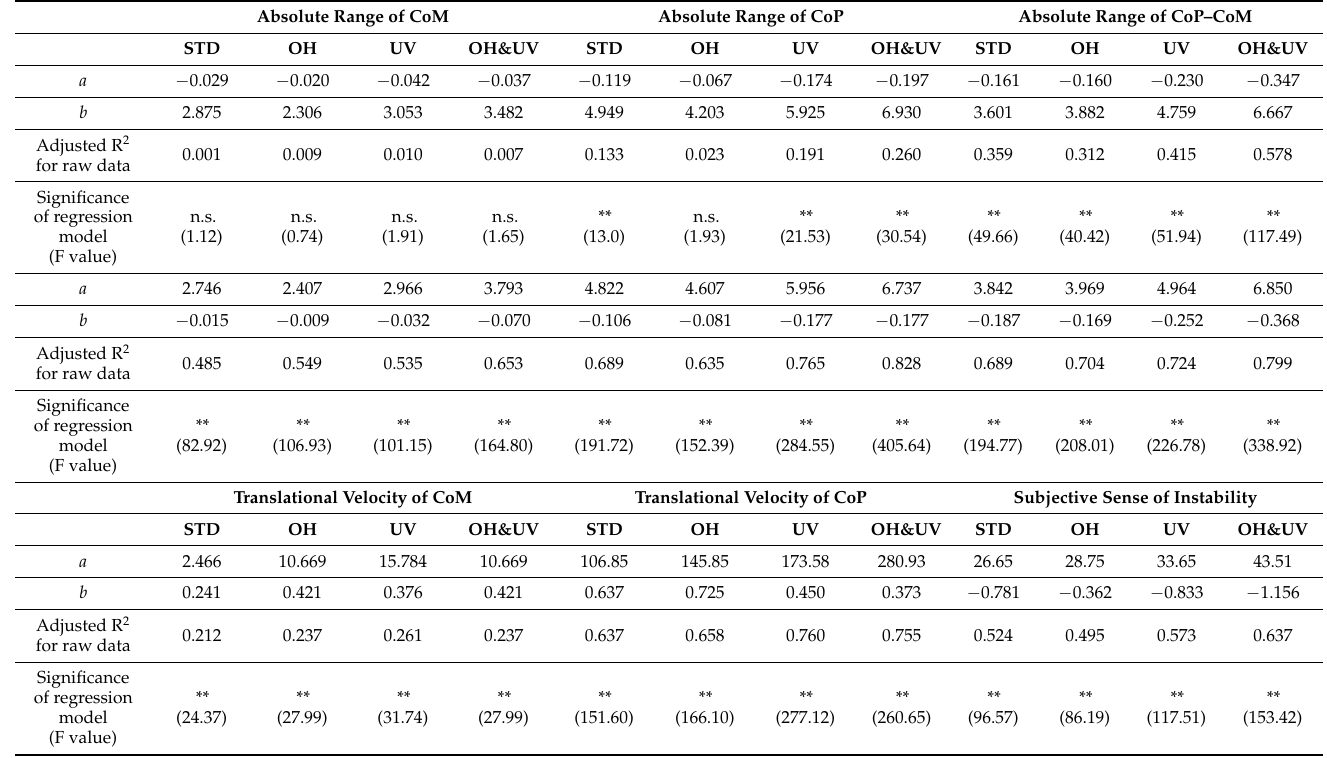
Table A2. Coefficients of fitting functions for kinematical indices and the significance test of regression model (** p < 0.01; n.s.: not significant). The models of the fitting functions were the linear for the platform depth ( y = a × d + b ) for the absolute range, the reciprocal of the platform depth ( y = a / d + b ) for the relative range and the subjective sense of instability, and the negative square of the platform depth ( y = a / d 2 + b ) for the translational